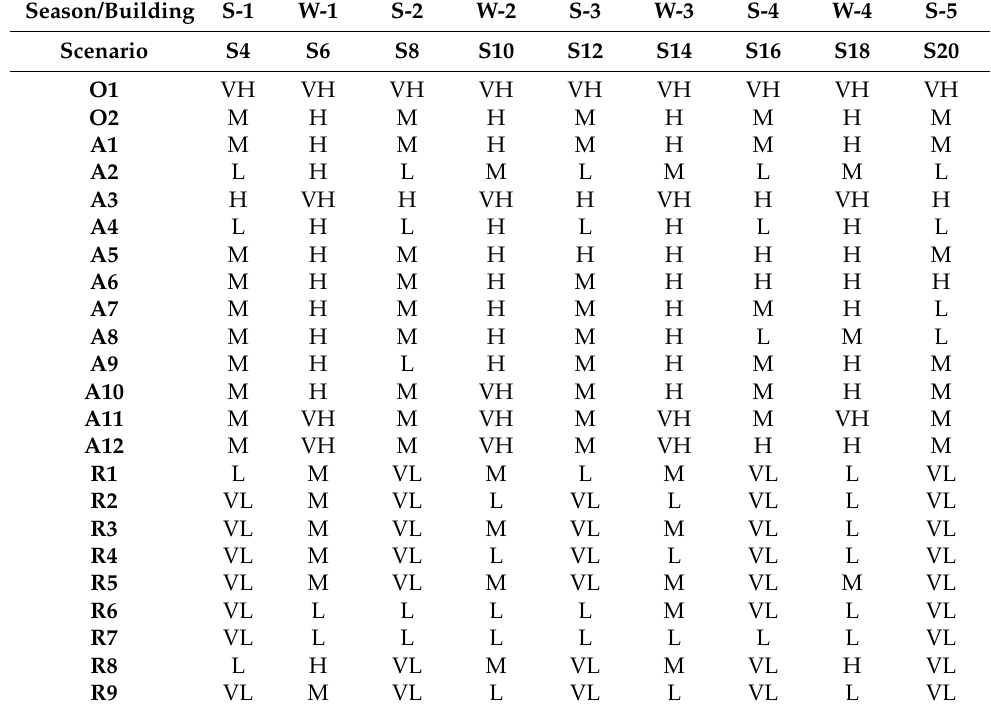
Table 5. Seasonal variation results of energy preference scenarios.